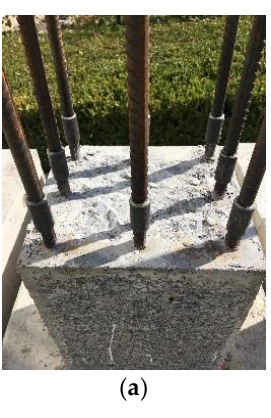
Figure 13. The main process of the second pouring. ( a ) Lengthening of the longitudinal bar. ( b ) Assembling reinforcement. ( c ) Formwork. ( d ) Finished secondary pouring.